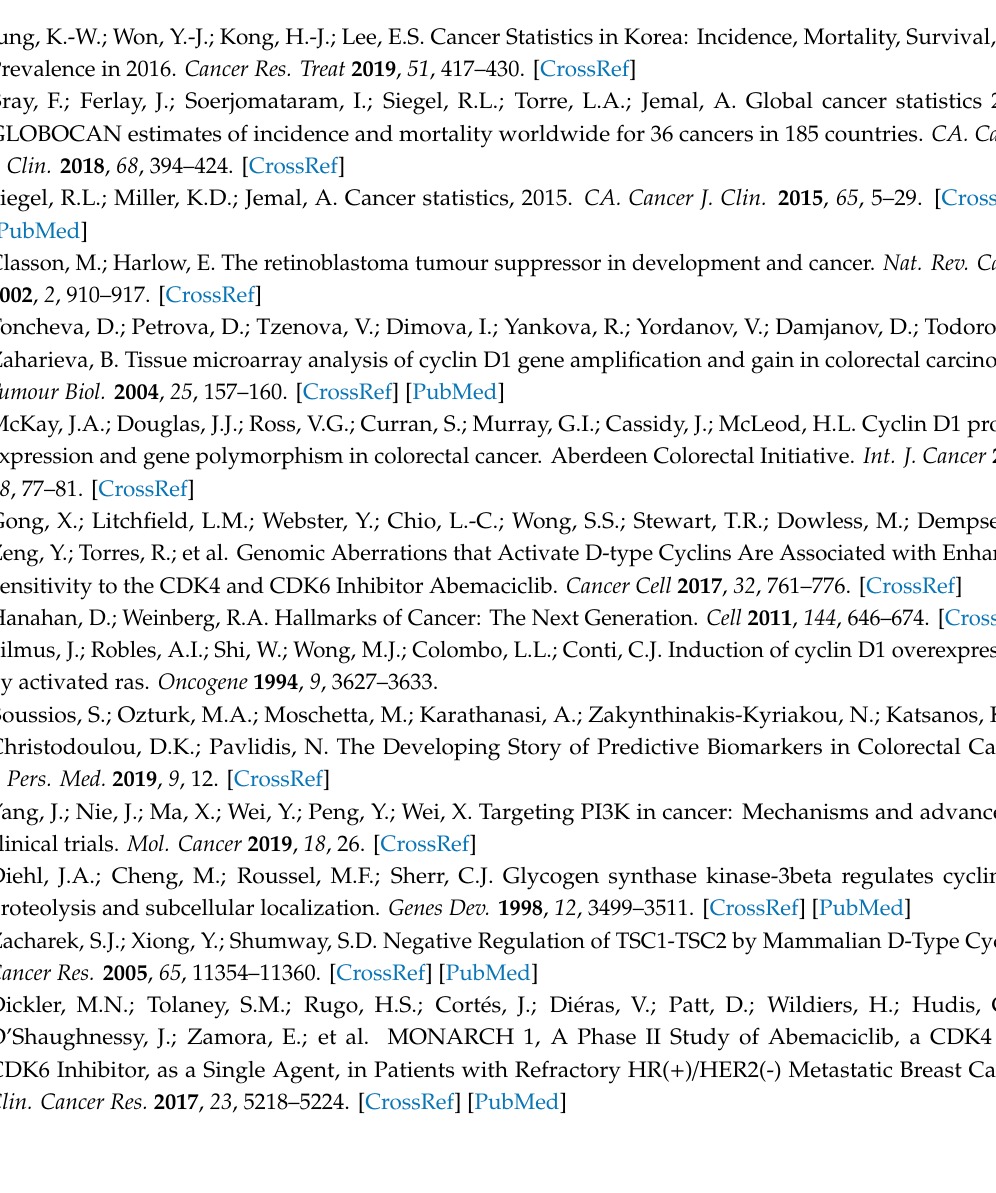
Figure S2: Uncropped Western blot images of indicated proteins in whole cell lysates from Caco-2 and SNU-C4 cells treated with and without abemaciclib, related to Figure 2A, Figure S3: Uncropped Western blot images of indicated proteins in whole cell lysates from Caco-2 and SNU-C4 cells treated with abemaciclib and / or BYL719, related to Figure